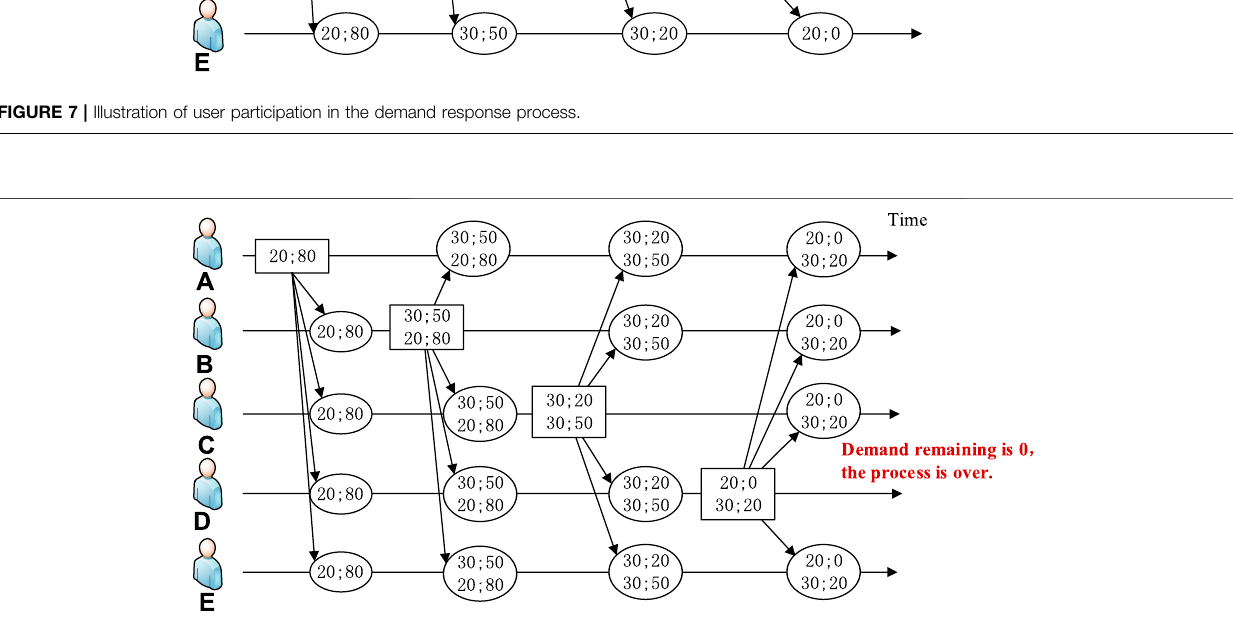
FIGURE 8 | Illustration using the weak-consistency strategy when the information is correct.